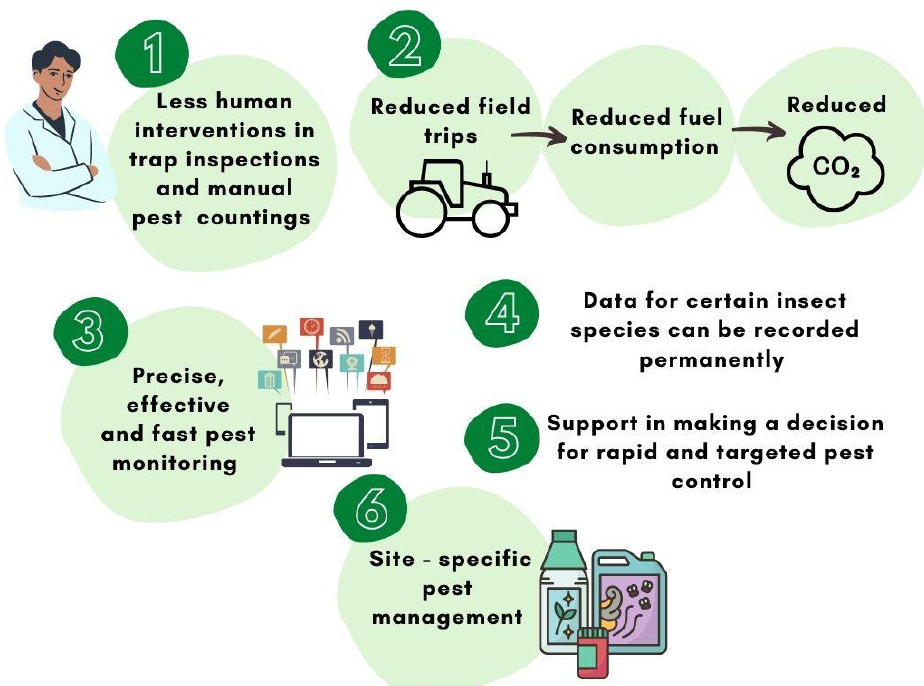
Figure 2. Major advantages of automatic pest monitoring systems.